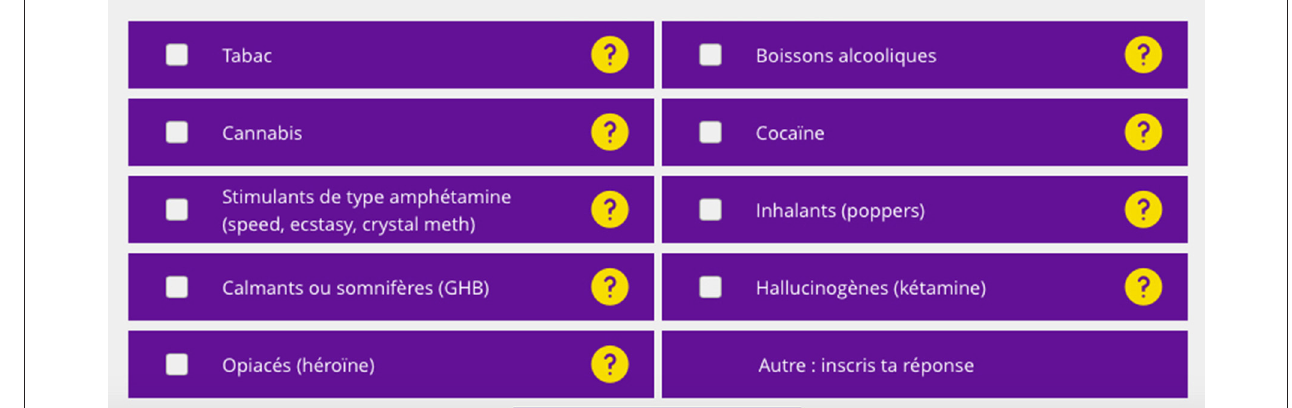
Frontiers in Psychiatry |